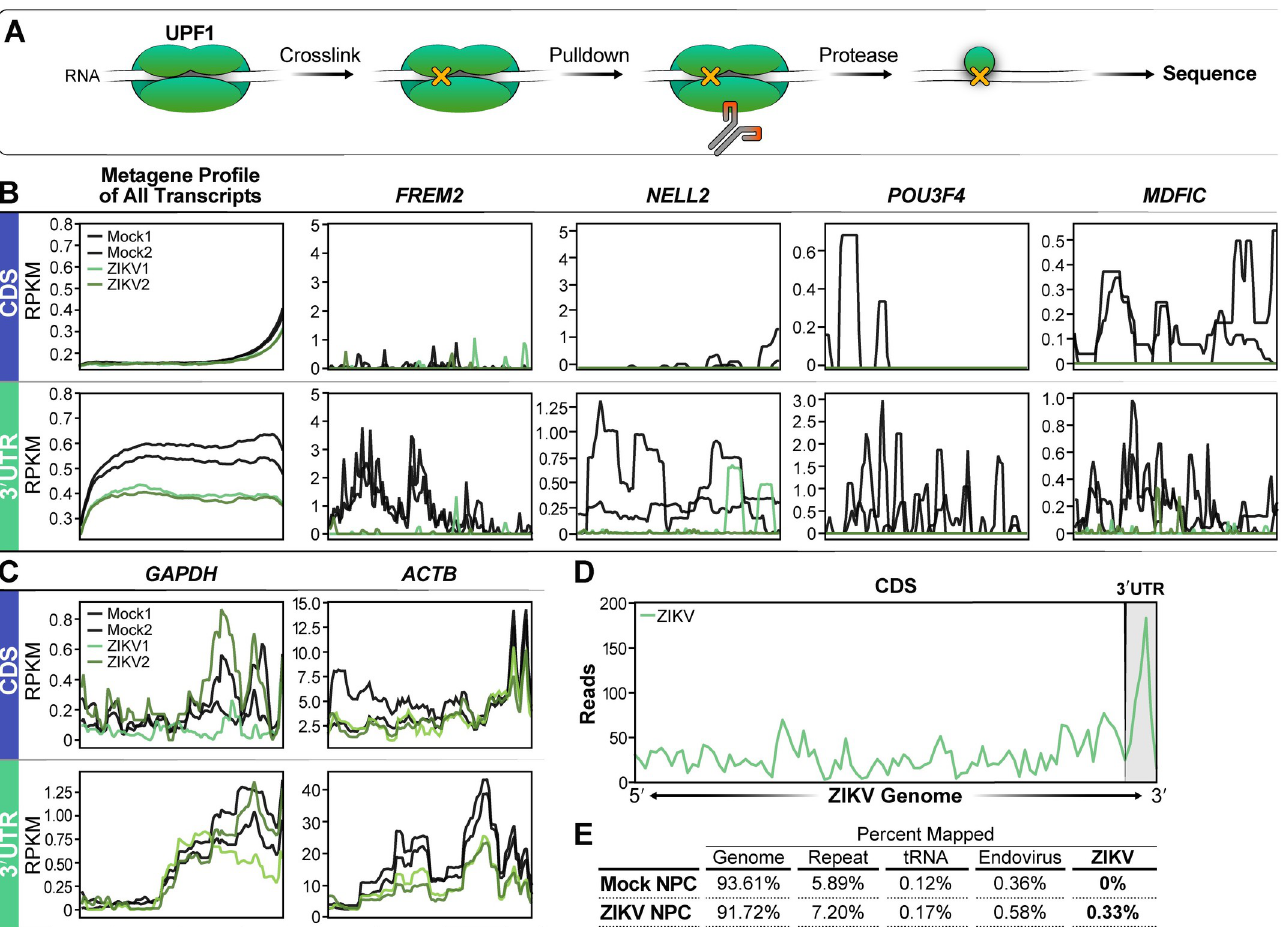
Fig 1. UPF1-host transcript interactions are decreased during ZIKV infection of NPCs. A) irCLIP schematic describing the workflow to obtain sequencing data. After 48 hrs of ZIKV infection, UPF1 and RNA are crosslinked using UV light, followed by UPF1 pulldown and protease degradation to expose the UPF1-bound RNA for sequencing. B) Metagene profile of all transcripts sequenced from the irCLIP experiment. The graphs show Reads Per Kilobase of transcript, per Million mapped reads (RPKM) values for positions in the Coding Domain Sequence (CDS) and the 3’UTR. Experiment was produced from 2 biological replicates. Representative metagene plots (FREM2, NELL2, POU3F4, MDFIC) of loci found to have a loss of UPF1 interaction. C) A metagene plot of GAPDH and ACTB are shown as controls. D) Metagene plot of reads mapping to the ZIKV genome, with the 3’UTR marked. E) Tabular breakdown of read map percentages from the UPF1-CLIP